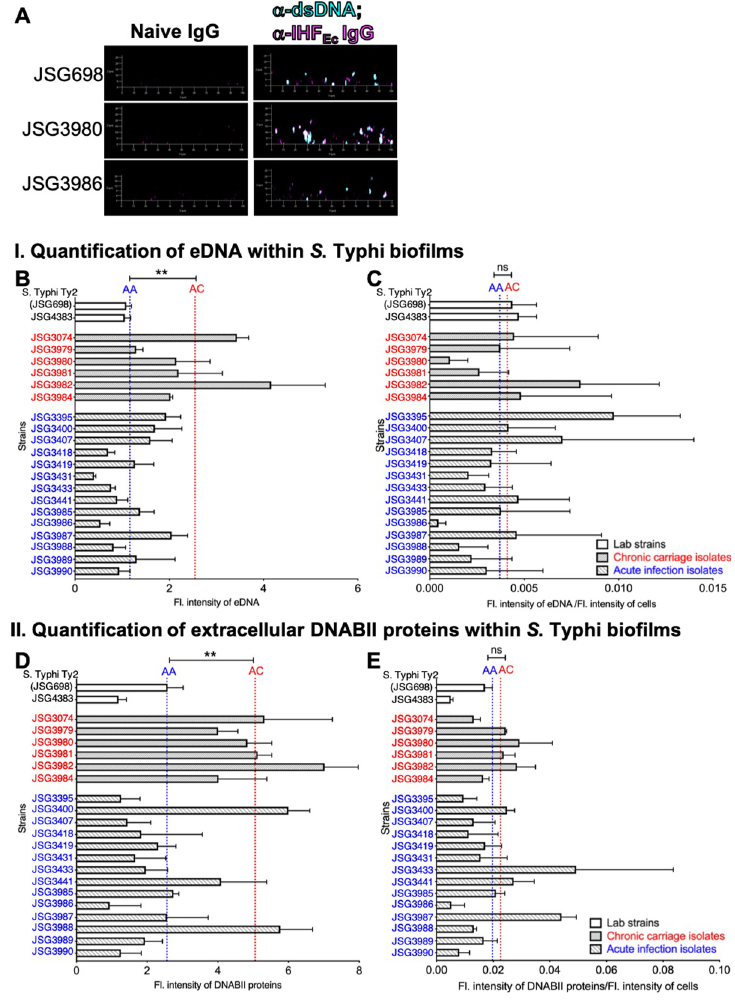
Fig 3. Chronic carriage isolates have higher steady levels of extracellular DNA and DNABII proteins within their biofilm EPS than acute isolates. Biofilms of each of the indicated S . Typhi strains were established in an 8-well chambered coverglass slide for 40 hours. Biofilms were labeled with α -dsDNA monoclonal antibody, α -IHF Ec and FM 4–64 and visualized via CLSM. ( A ) Representative immunofluorescence images of a lab wild type strain S . Typhi Ty2 (JSG698), chronic carriage isolate (JSG3980) and acute isolate (JSG3986). eDNA is visualized in teal and DNABII proteins in purple. Images were analyzed by ImageJ to quantify the fluorescence intensity of eDNA ( B ), DNABII proteins ( D ), and bacteria. Fluorescence intensity of eDNA and DNABII proteins were normalized to cells and plotted in ( C ) and ( E ), respectively. Bars represent the SEM. AA and AC represent the averages of acute infection isolates and chronic carriage isolates, respectively. Statistical significance between AC and AA were assessed by a one-way ANOVA followed by Tukey’s multiple comparison test. �� P < 0.01. On average, chronic carriage isolates had higher steady state levels of both eDNA and DNABII proteins within the biofilm EPS as compared to acute isolates. Chronic carriage isolates are indicated in red and acute infection isolates are indicated in